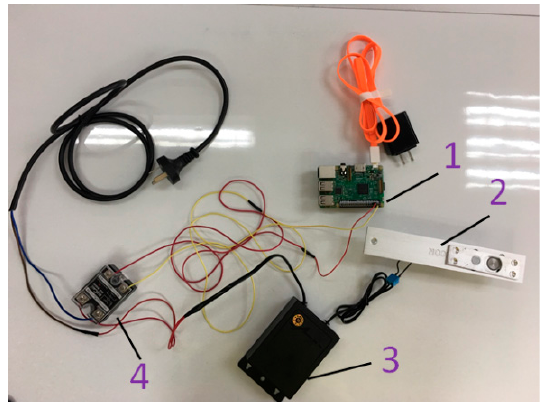
Figure 18. A physical connection diagram of the mailbox.